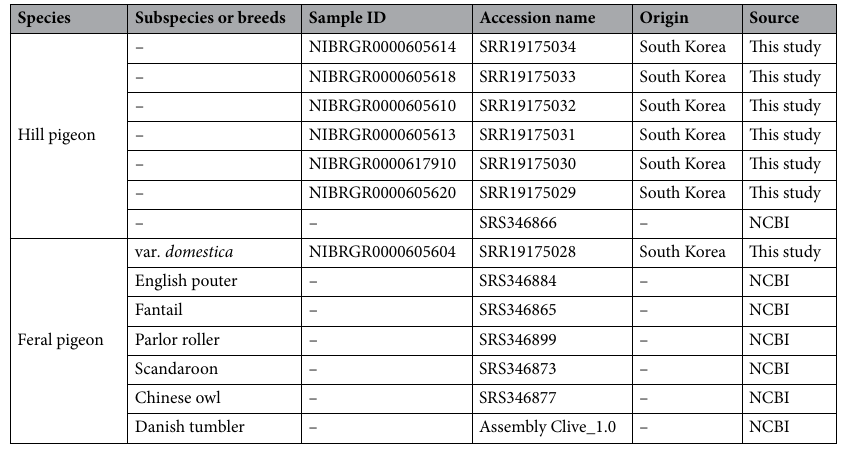
Table 4. Whole-genome re-sequencing sources of seven hill pigeons ( Columba rupestris ) and seven feral/ domestic pigeons ( C. livia var . domestica